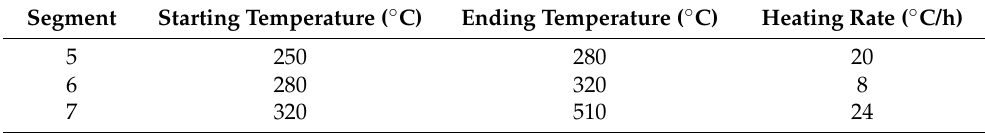
Table 2. Cont. Segment Starting Temperature ( ◦